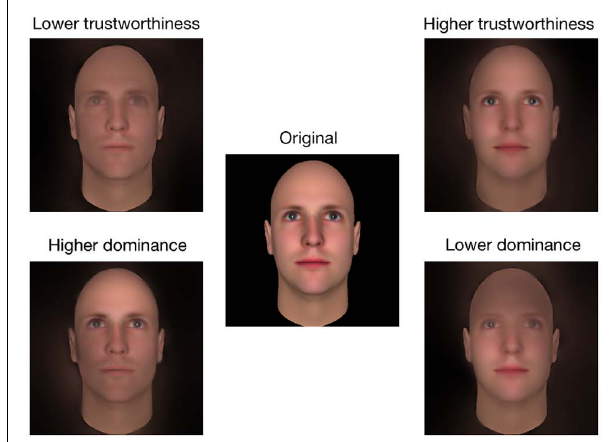
FIGURE 5 | Examples of the stimuli used in Experiment 2. Both pro- and anti- version of each social judgment as well as the original stimulus for the computer-generated faces are shown.